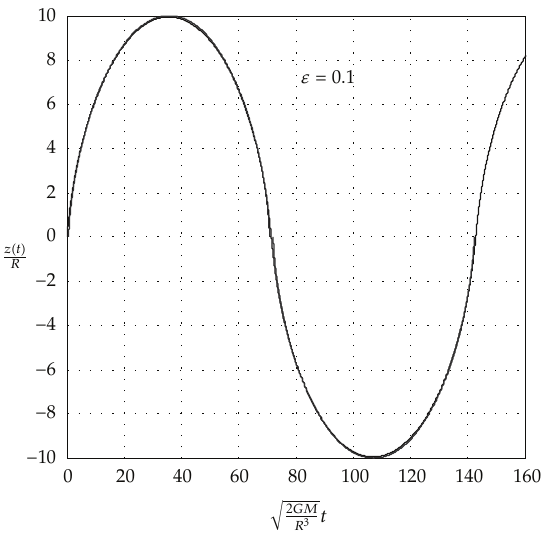
Figure 4: The function z (cid:4) t (cid:5) with ε (cid:7) 0 . 1, the solid line corresponds to numerical integration of (cid:4) 3.1 (cid:5) , the dashed line represents the outer solution (cid:4) 3.23 (cid:5)